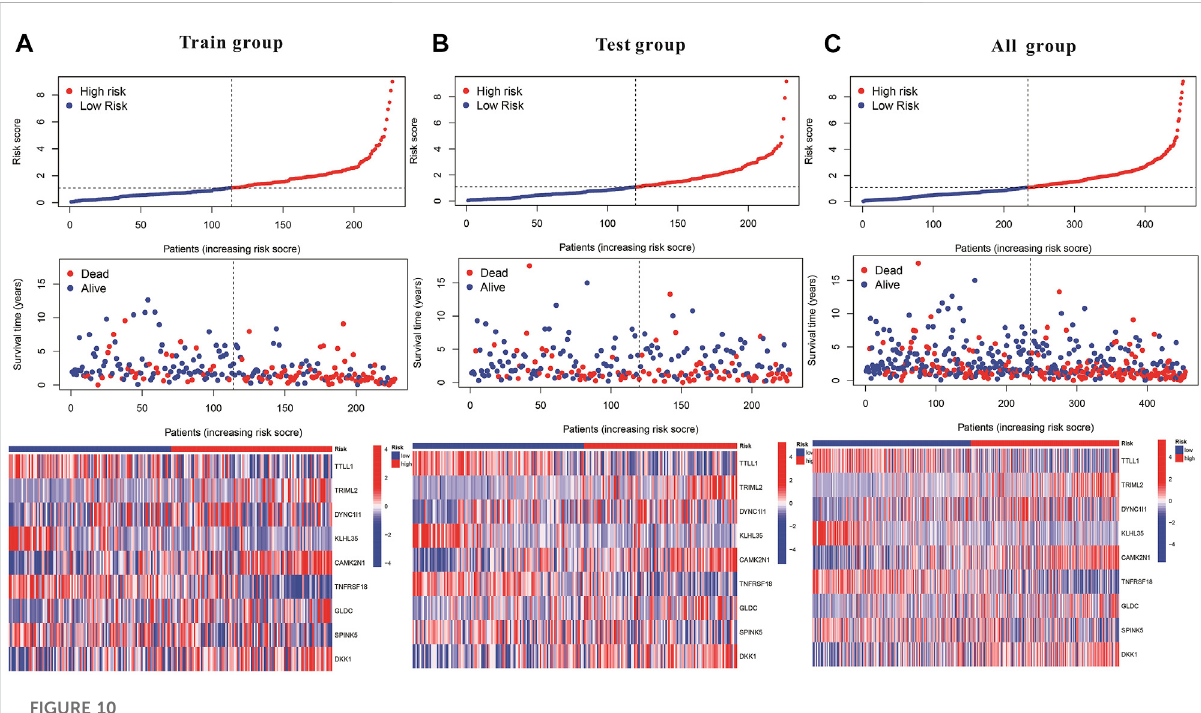
FIGURE 10 Kaplan – Meierandprognosticriskcurves. (A) Traingroup. (B) Testgroup. (C) Allgroups.Thedottedlineindicatesthepersonalin fl ectionpointof the risk score, and patients are divided into low- (green) and high-risk (red) groups. Red dots represent patients who are dead, and green dots represent those who are alive. As the risk score increased, numerous patients died. Colors from blue to red indicate low to high expression